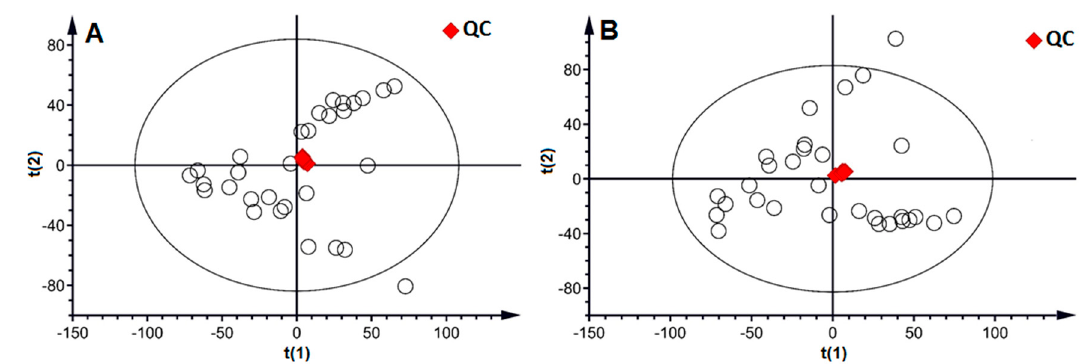
Figure 2. The PCA score plot of all samples ( ) with the highlight of the QC ( ◆ ) sample in positive ion mode ( A ) and negative ion mode ( B ).